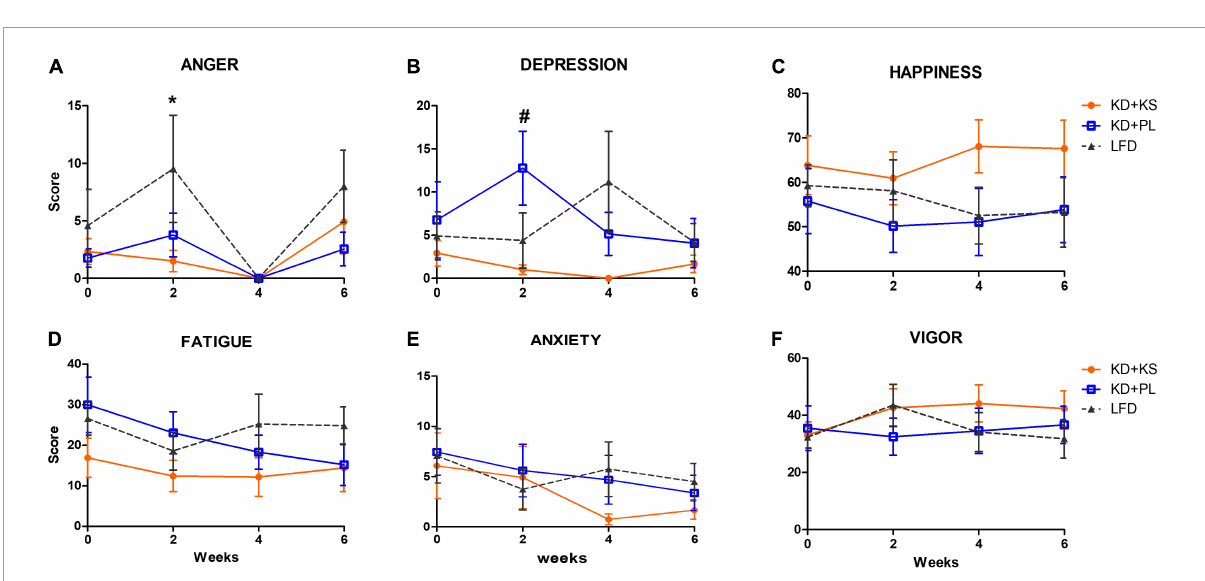
FIGURE3 Profile of Moods assessments in all diet groups. (A) Increased anger scores were observed in LFD group when compared to KD at week 2. Depression scores (B) were higher at week 2 for KD + PL group, compared to KD group supplemented with KS. No statistically significant differences were observed in happiness (C) , fatigue (D) , anxiety (E) , and vigor (F) scores. Values represent mean ± SEM. KD, ketogenic diet; KS, ketone supplement; PL, placebo; LFD, low-fat diet. Data included in Supplementary Table 1 but not shown in this figure: Sleepiness, restlessness. * p < 0.05 vs. LFD, # p < 0.05 vs. KD +